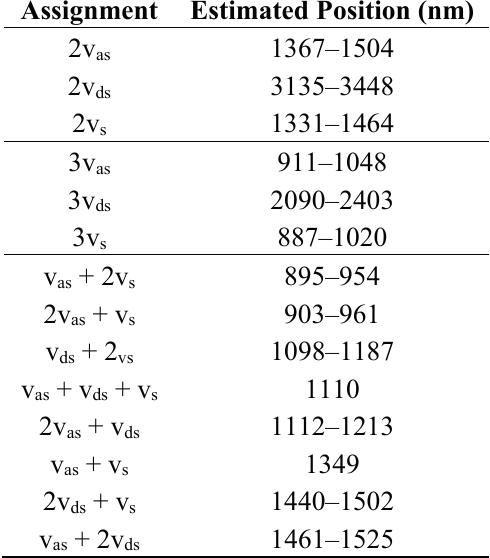
Table 1. Estimated positions of overtones and combinations of fundamental asymmetric, symmetric and bending vibrations of the water molecule (v as , v s and v ds respectively) calculated using Equation